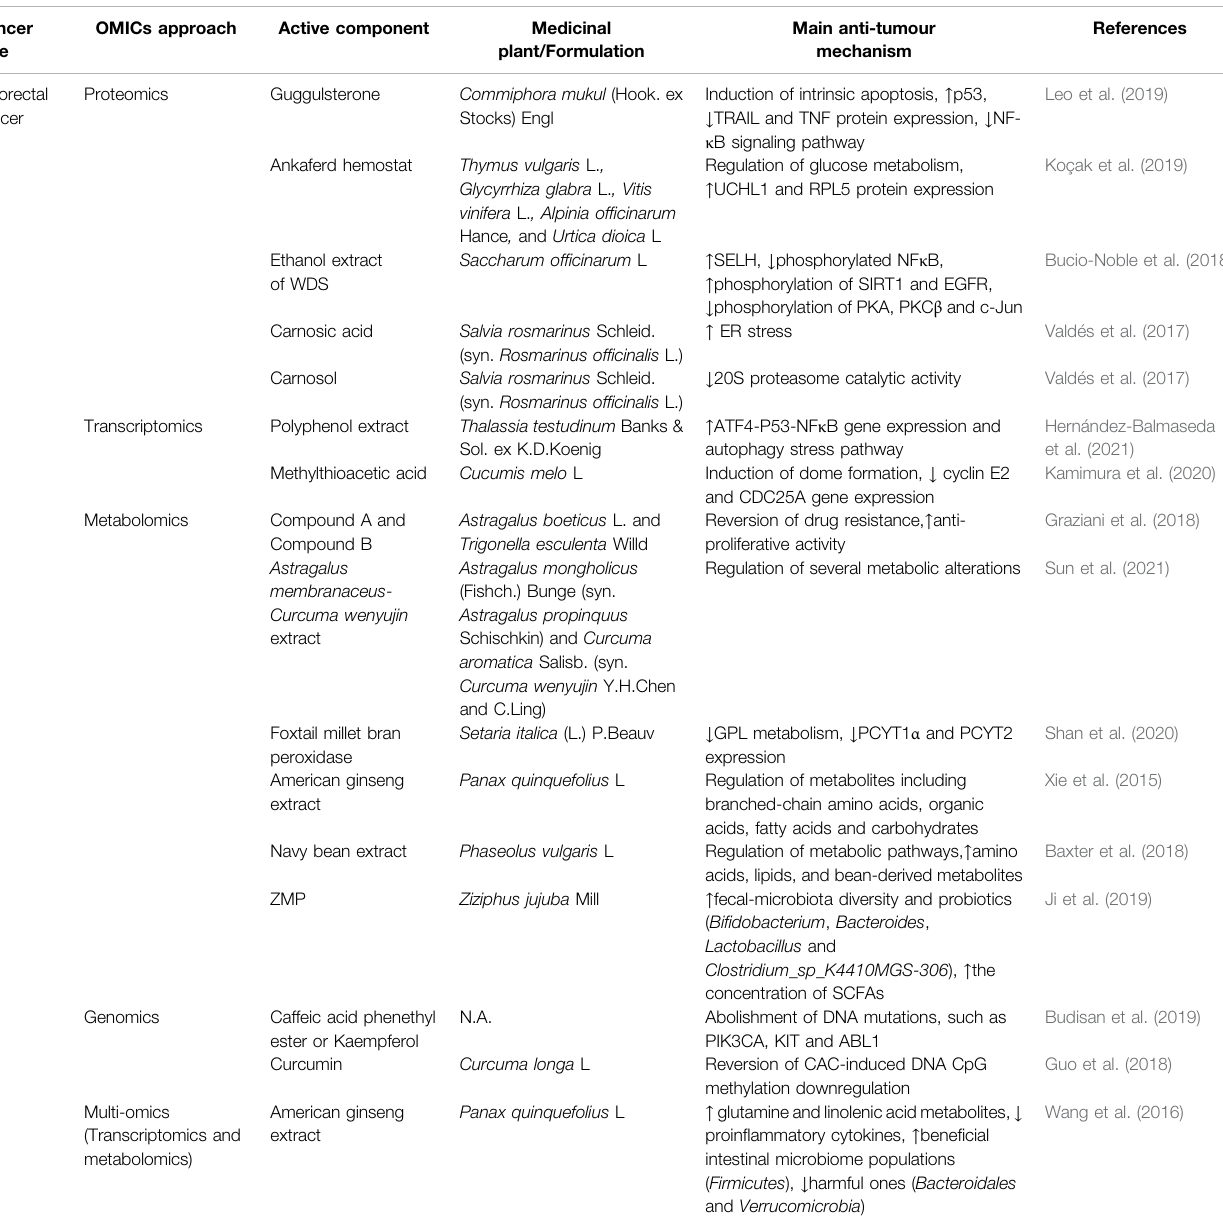
TABLE 1 | The applications of OMICS on medicinal plants in Colorectal